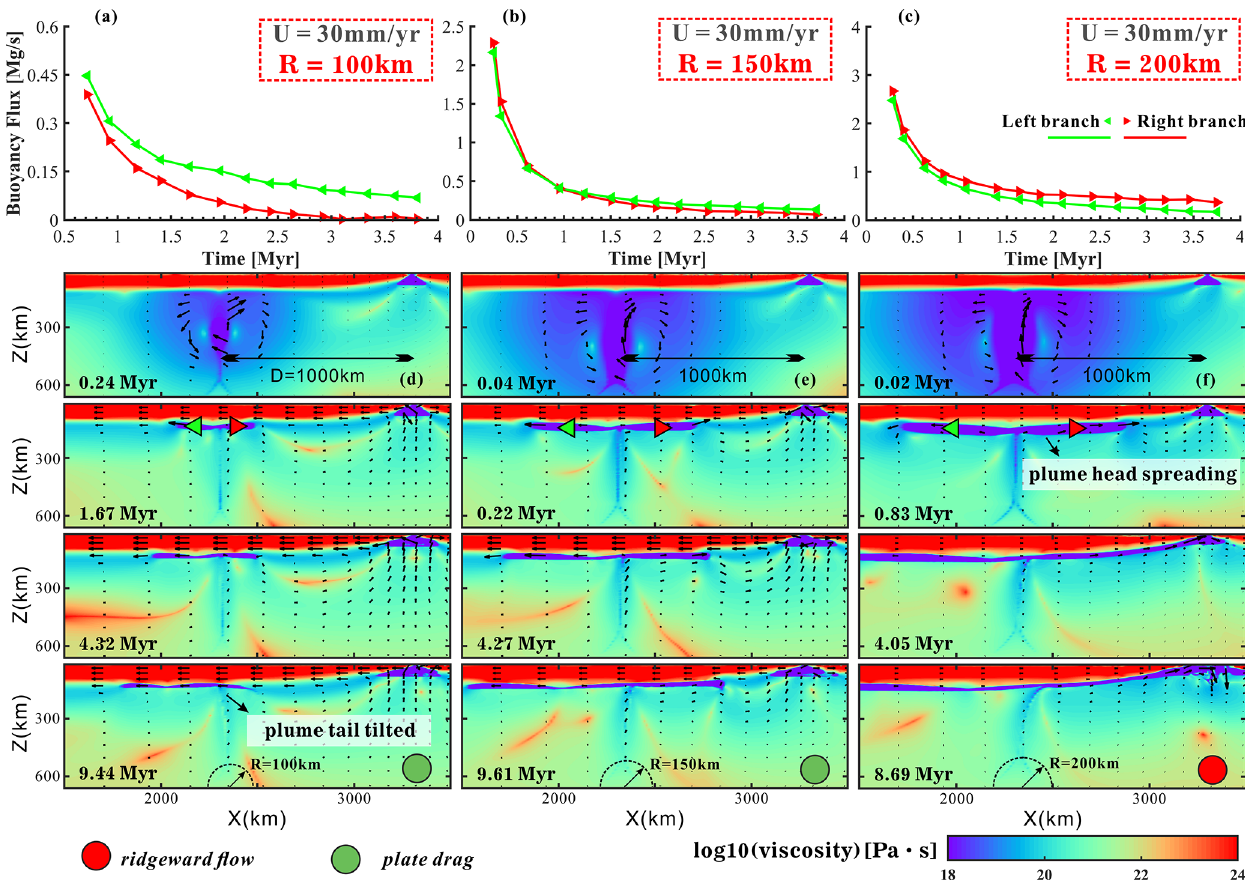
Figure 6. Models varying initial plume head radii (model M53, M58 and M63; Table S1) shown by buoyancy flux and viscosity. (a– c) Buoyancy flux in spreading plume branches over time. Green and red triangles are markers used for buoyancy flux calculations for the left and right plume branches, respectively. U and R stand for half of the spreading rate and plume radius. (d–f) Viscosity snapshots of models with different plume head radii. Models with green circles represent plate-drag plume flow, and ridgeward plume flow is represented in